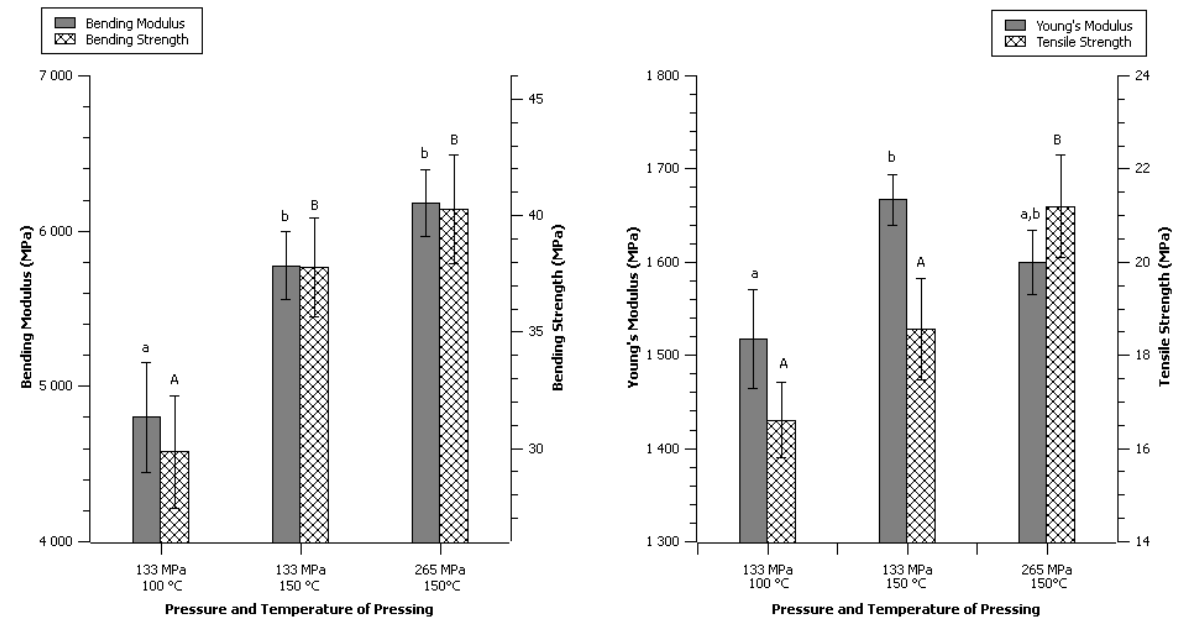
Figure 5. Effect of compression pressure and low temperature. Data are given as mean ± confident interval (95%). The letters on top of the column express significant difference of means according to Scheffé test with a 95% confident level. Small letters for moduli and capital letters for